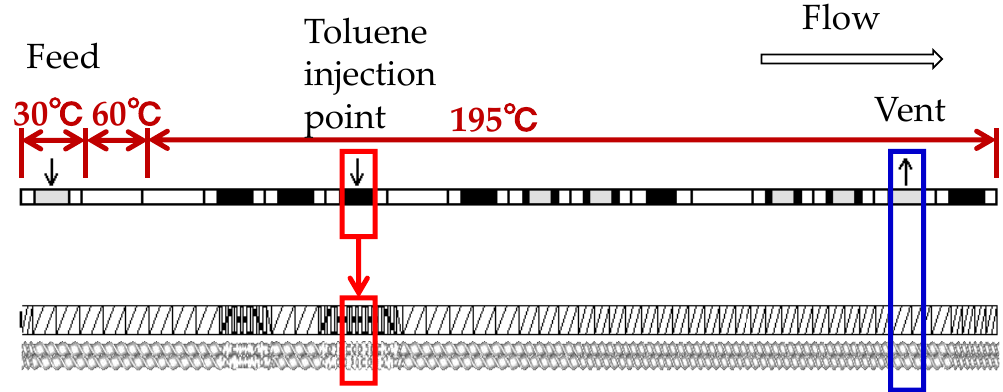
Figure 5. Schematic diagram of the apparatus configuration.